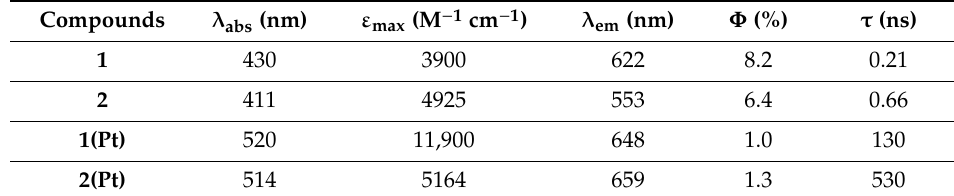
Figure 2. Absorption spectra ( a ) and fluorescence and phosphorescene spectra ( b ) of ligands 2 and 1 and complexes 2(Pt) and 1(Pt) (for each compound, obtained by exciting at their absorption maximum wavelength) in CH 2 Cl 2 at 25 °C. Table 2. Photophysical parameters of the platinum complexes 2(Pt) and 1(Pt) and of their corresponding neutral ligands 1 and 2 in CH 2 Cl 2 at 25 ◦